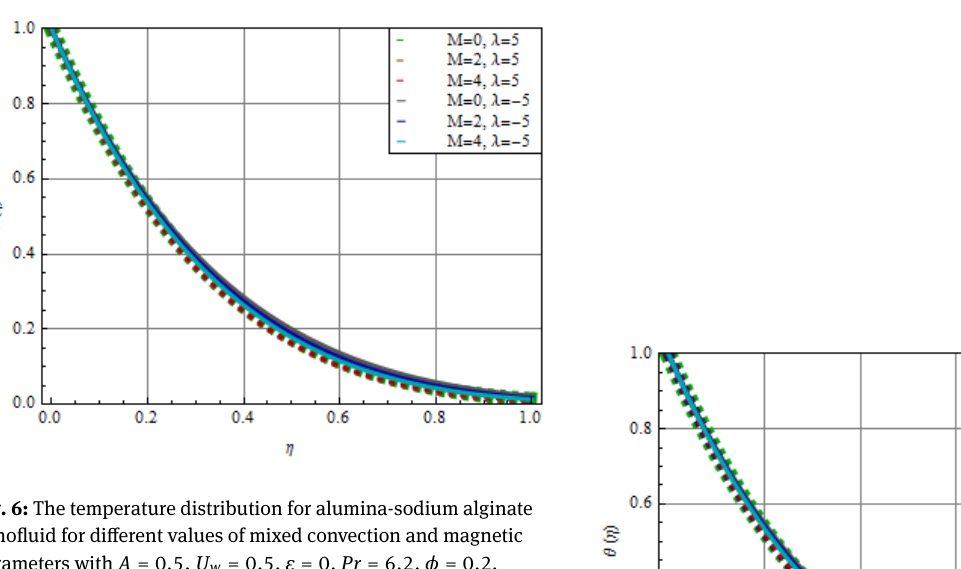
Fig. 5: The velocity distribution for alumina-sodium alginate Fig. 7: The velocity distribution for alumina-sodium alginate nanofluid for different values of mixed convection and magnetic nanofluid for different values of mixed convection and unstediness parameters with A = 0.5, U = 0.5, ε = 0, Pr = 6.2, ϕ = 0.2. w